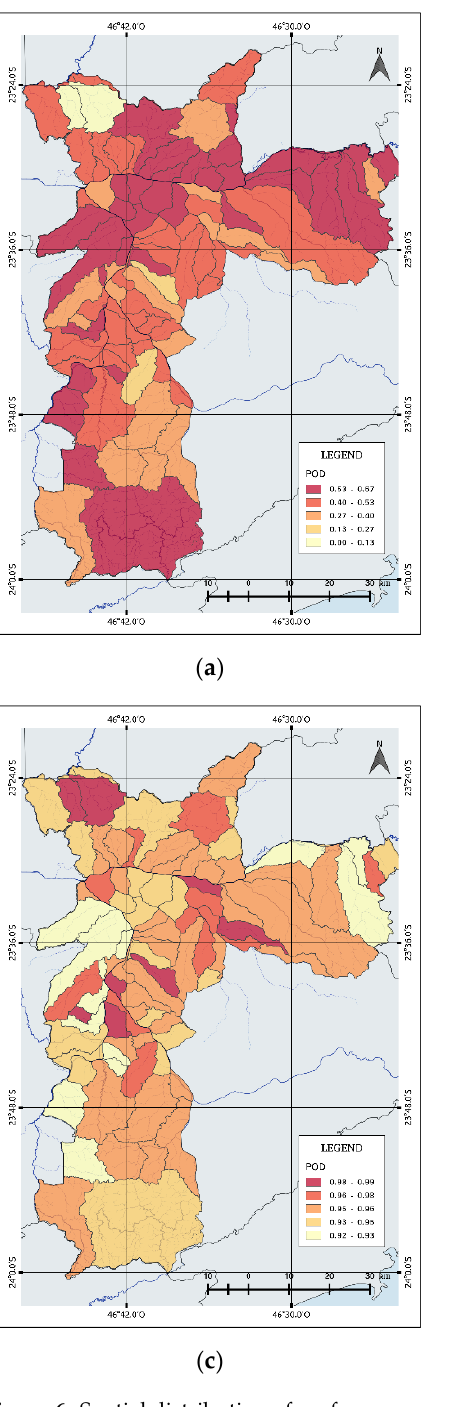
Figure 6. Spatial distribution of performance metrics, which include the probability of detection (POD) and false alarm ratio (FAR), in São Paulo for flash flood and non-flash flood events: ( a, b ) the POD and FAR of flash flood events, and ( c, d ) the POD and FAR of non-flash flood events.